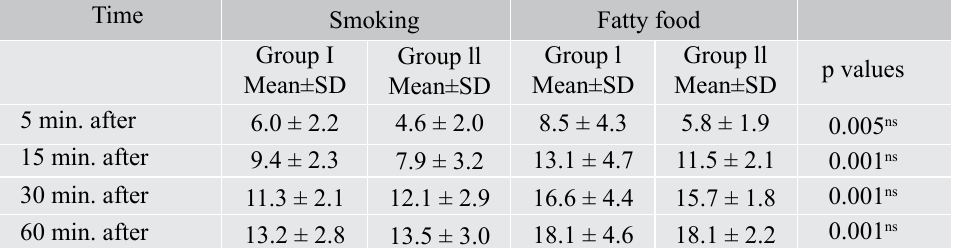
Table VI: Mean comparison of net change of gallbladder volume (in cm 3 ) between before and after smoking and fatty food intake in both groups (N=30)